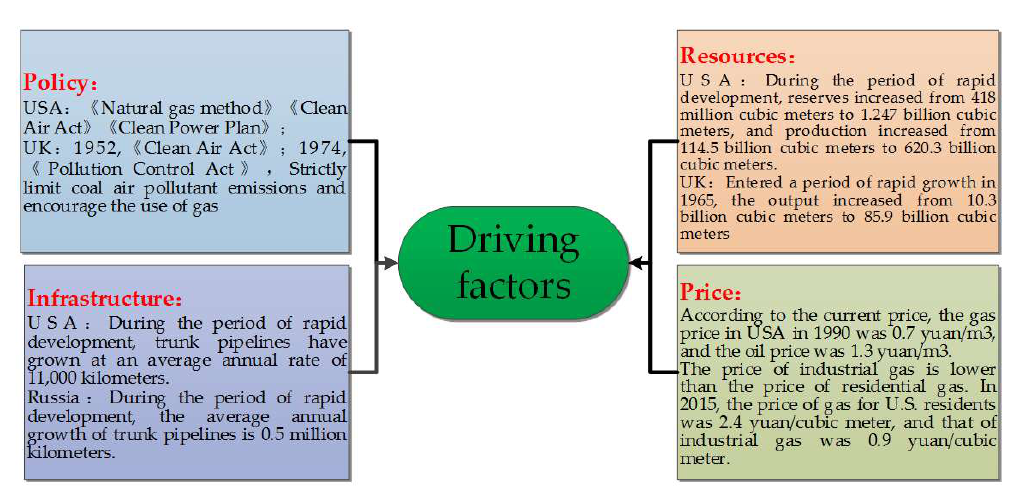
Figure 2. Four major driving forces for the growth of natural gas consumption.